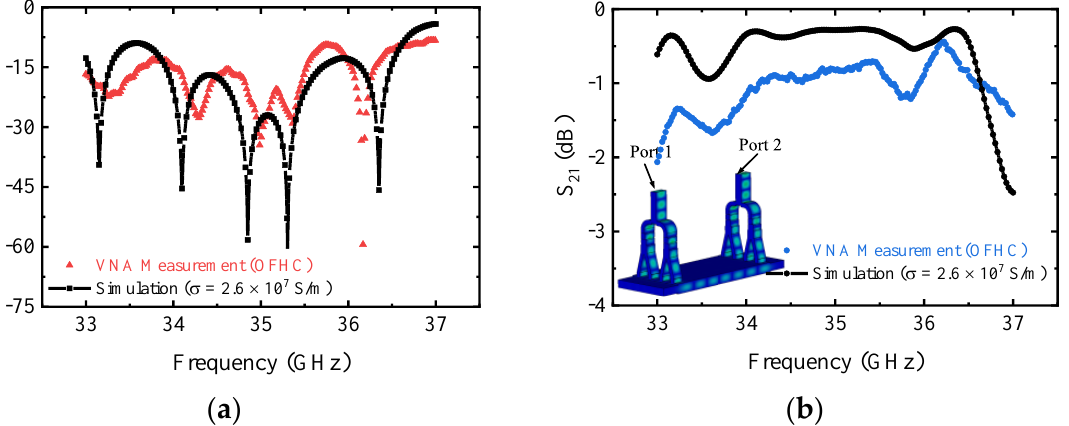
Figure 7. Comparison of the simulation and measurement results of the mode converter ( a ) S 11 and ( b ) S 21 .